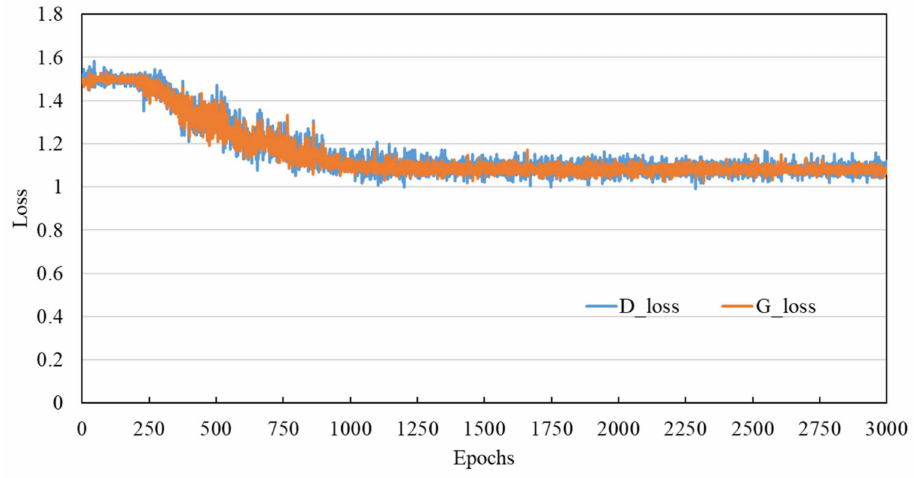
Figure 6. The discrimination loss and generation loss curve of the ACGAN-SN